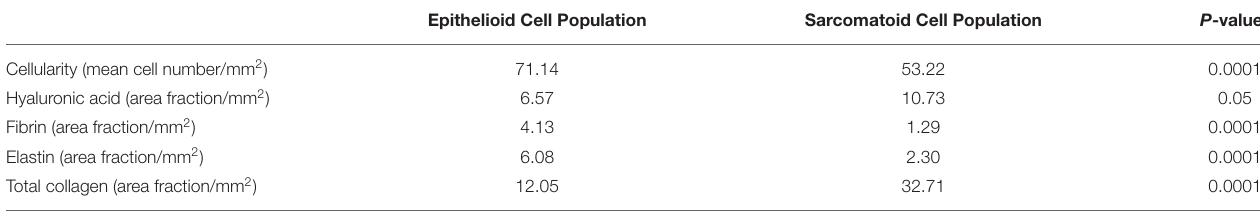
TABLE 2 | Differences in the decomposed extracellular matrix factors between the epithelioid and sarcomatoid cell populations in